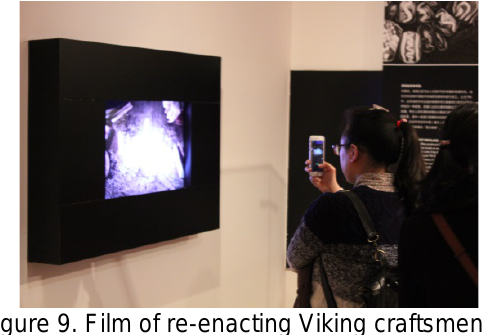
Figure 9. Film of re-enacting Viking craftsmen on display is being recorded onto a museum